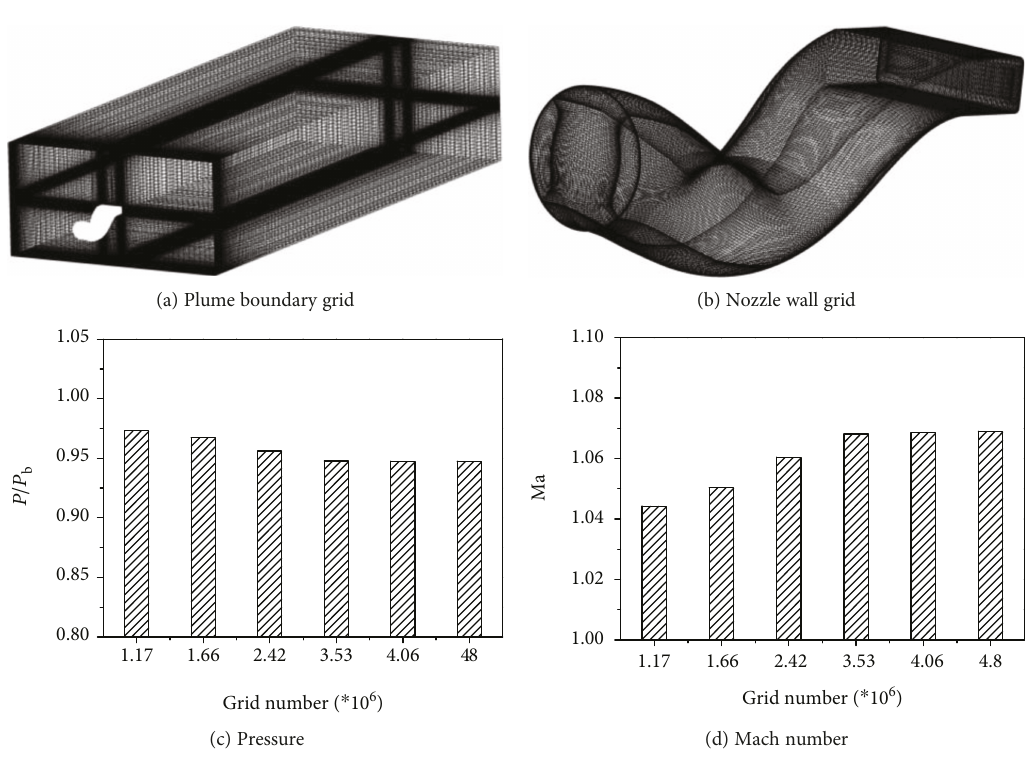
Figure 7: Schematic computational grids and grid